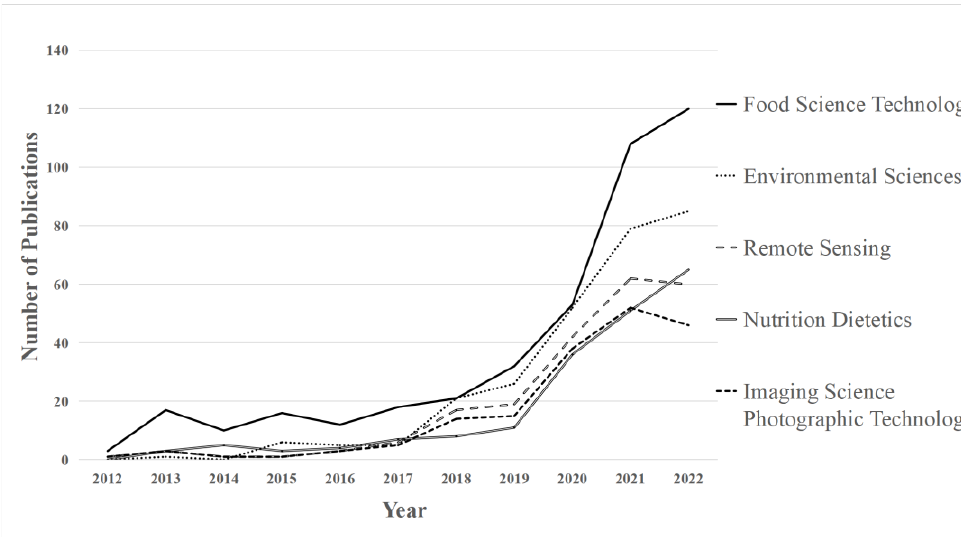
Figure 4. Annual publications within the five most popular subfields.